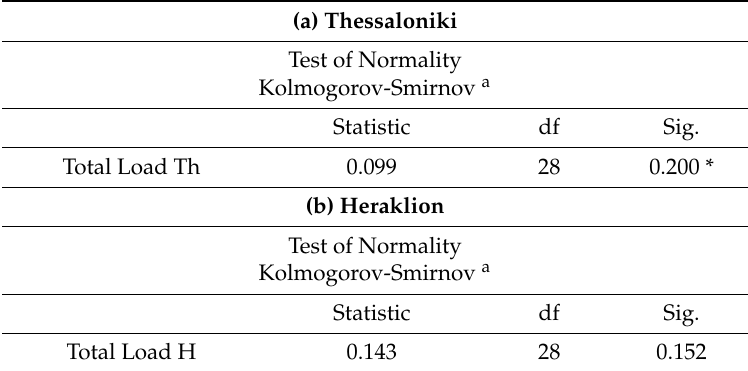
Table 14. Tests of normality for the dependent variables: ( a ) Total Load for Thessaloniki (Total Load Th) and ( b ) Total Load for Heraklion (total Load H).